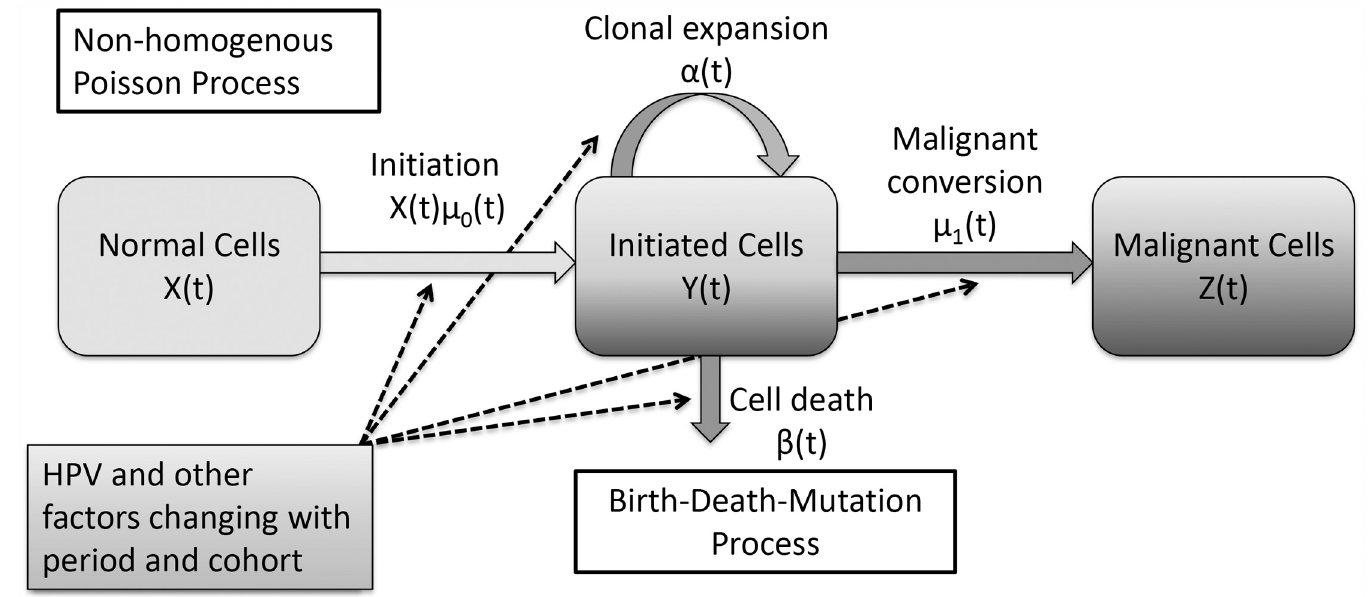
Fig 1. Schematic of the two-stage clonal expansion model with period and cohort